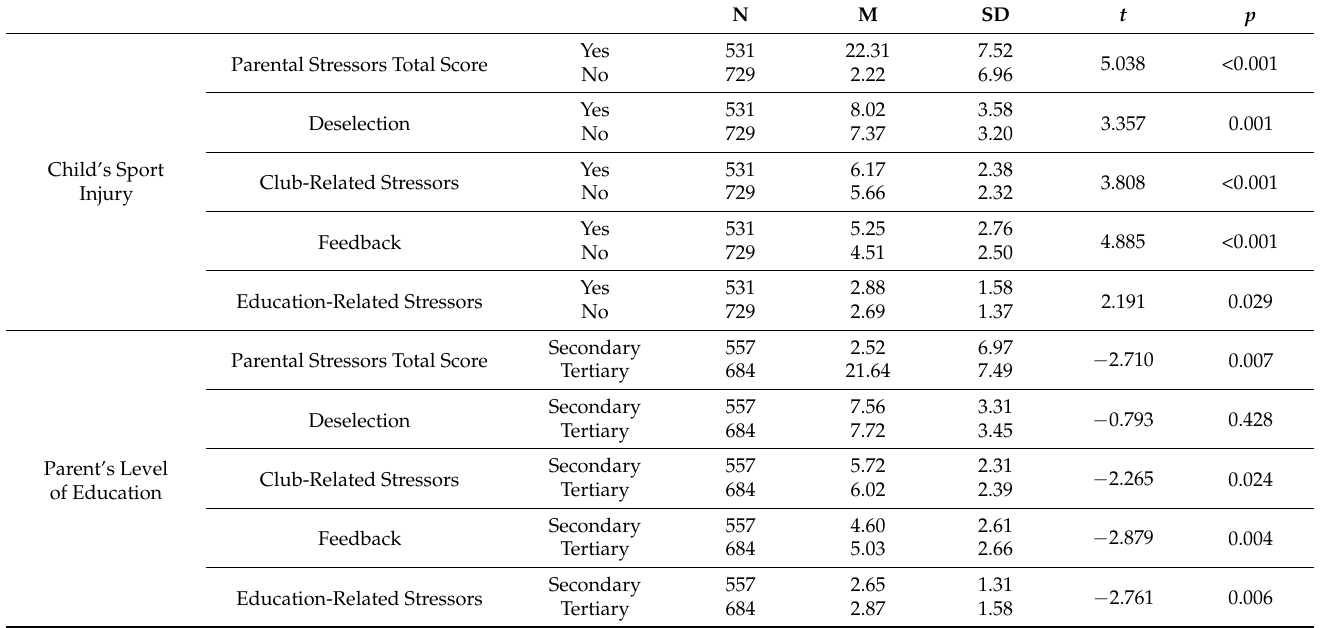
Table 3. Differences in parental stress by children’s sports injury (vs. non-injury) and parents’ level of education. N M SD t